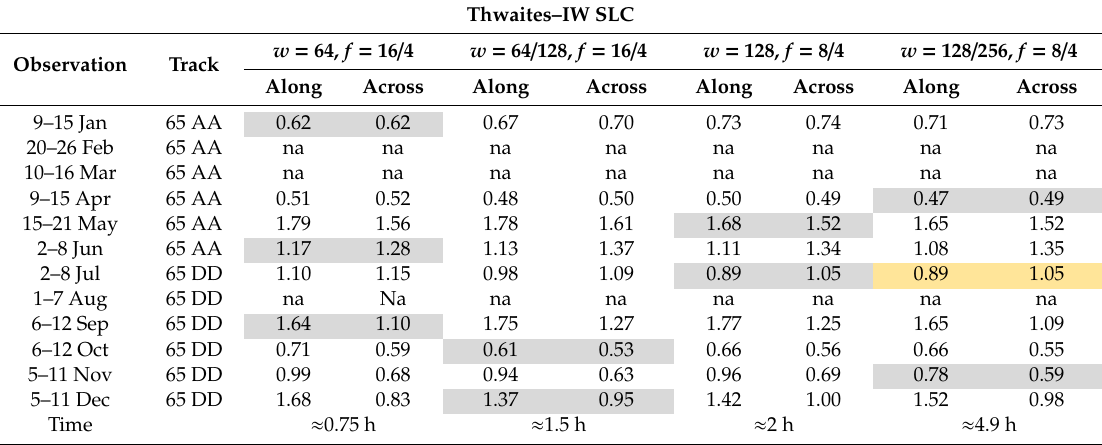
Table 10. THW, IW SLC product class experiments, RMSE (expressed in m / day) with respect to available literature data measured along selected along / across flow transects.